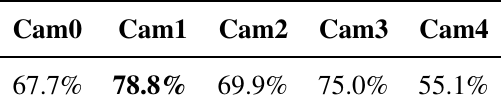
Table 1. A comparison of single-view recognition rates obtained on the IXMAS dataset. The result of the Leave-one-actor-out (LOAO) cross-validation is shown (bold indicates the highest). Note that Cam1 corresponds to the front view in most